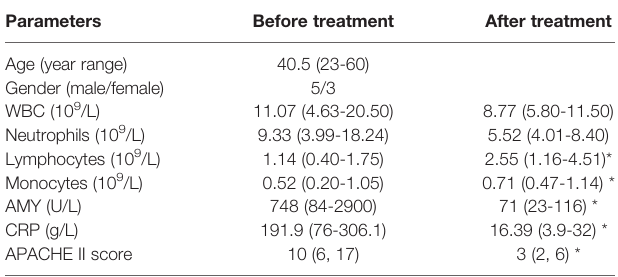
TABLE 2 | Effect of treatment on the values of clinical measures in follow-up AP patients. Parameters Before treatment After